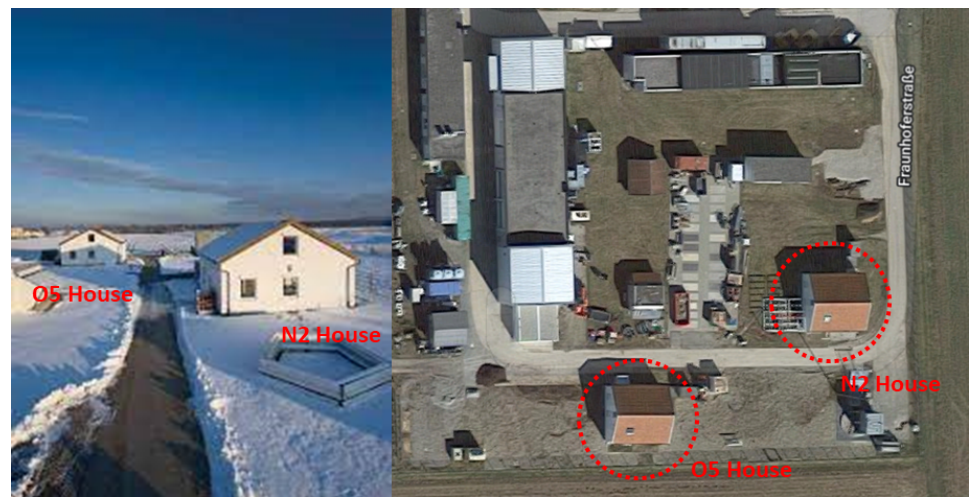
Figure 5. External views of the twin houses (N2 and O5), Holzkirchen, Germany